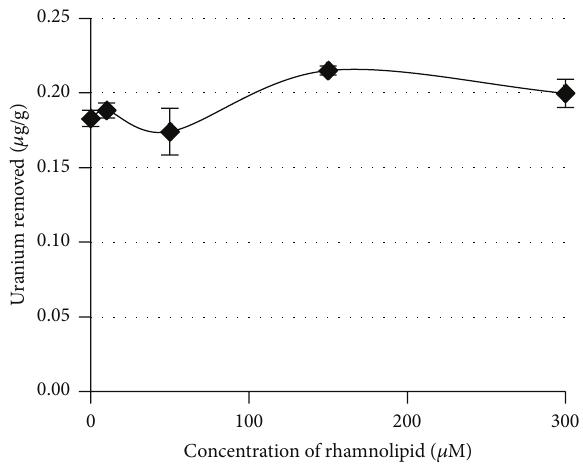
Figure 1: Removal of uranium as a function of the concentration of microbial rhamnolipid in the solution is